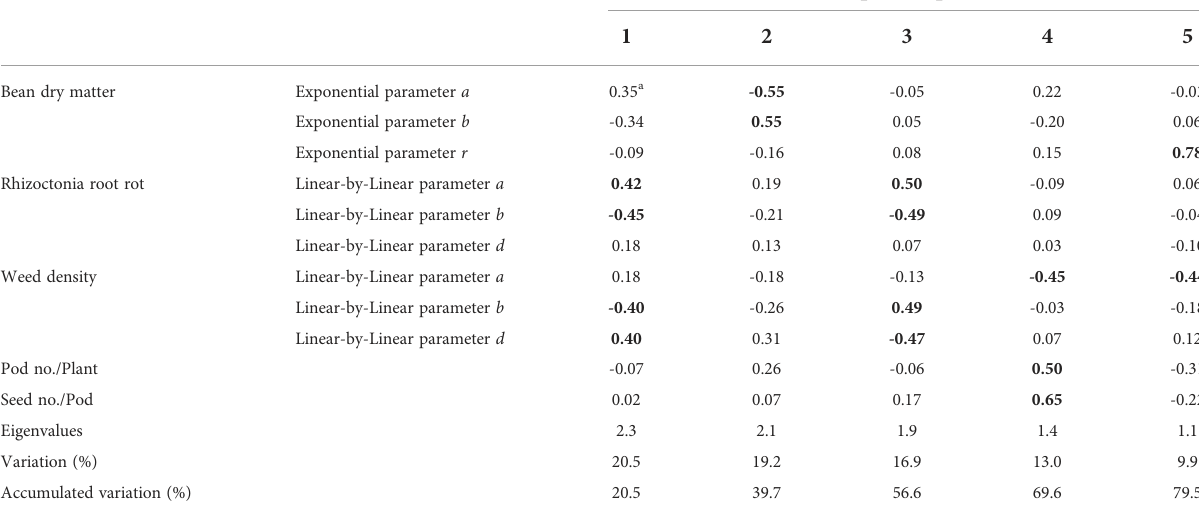
TABLE 5 Principal component analysis of plant production, Rhizoctonia root rot, and weed development in bean cultivars planted at different dates and weed control treatments.